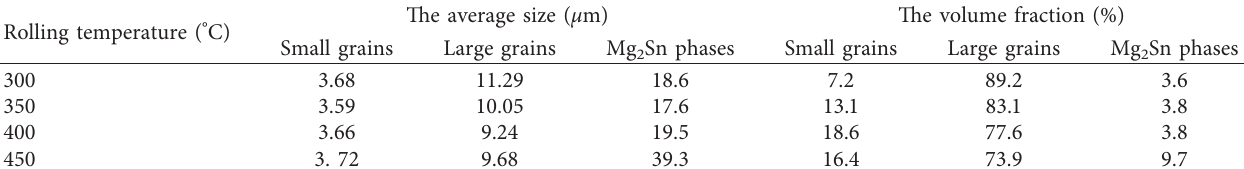
2 Sn phases, small grains, and big grains of alloys rolled at different temperatures.